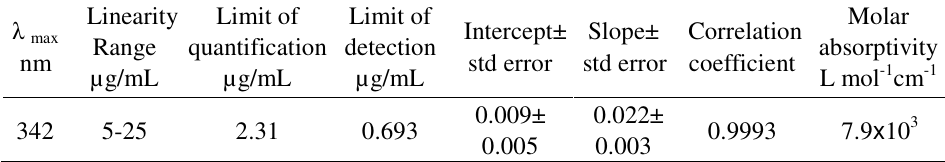
Table 2. Spectral data of the reaction of cefadroxil with sodium hydroxide